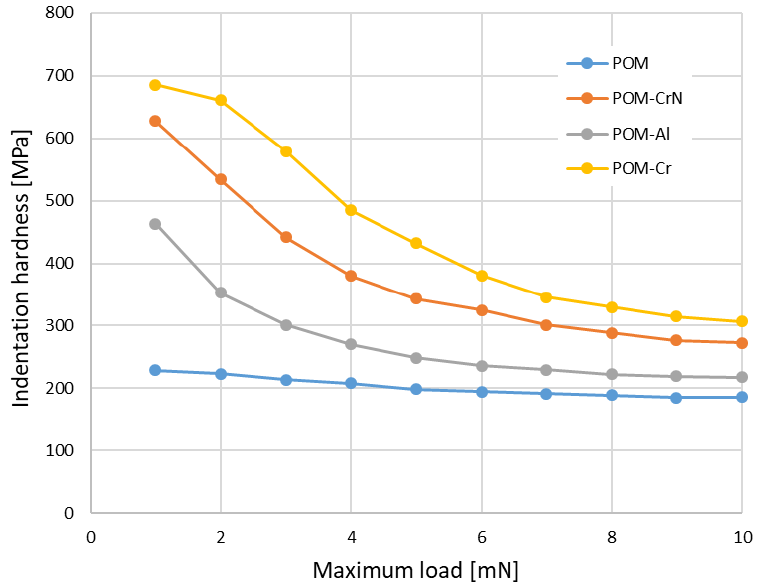
Figure 3. Indentation hardness of POM and coated POM in dependence of the maximum load during indentation experiments.